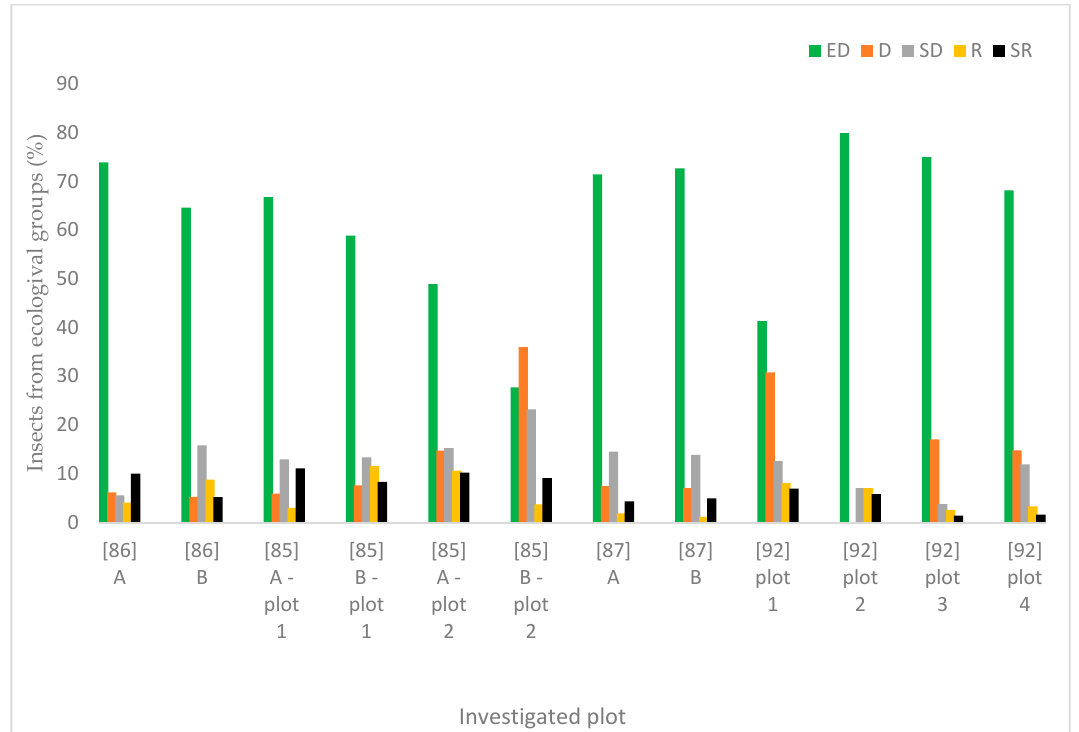
Figure 8. Structure of dominance in the Carabidae population based on the percentage of insects from particular groups (ED—eudominants; D—dominants; SD—subdominants; R—recedents; SR—subrecedents). This diagram was made based on selected publications, including data on the ecological characteristics of Carabidae communities inhabiting the investigated plants. (A—first year of investigations, B—second year of investigations).